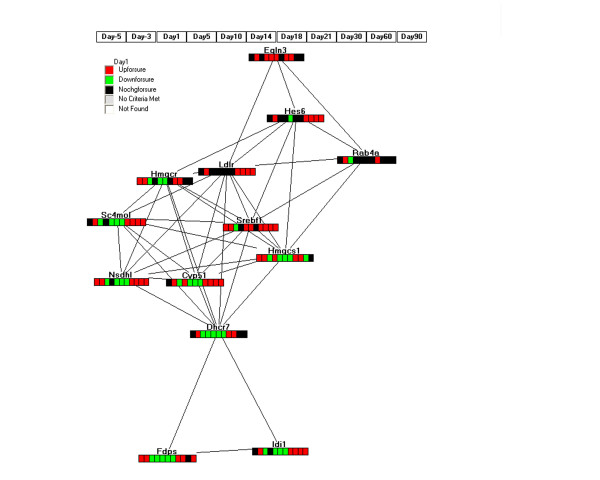
Manipulation and filtering of GTAN to gain insights of gene-gene relationships. The GTAN from Fig. 12 was merged into a gene-gene network through shared terms: if two genes share a common term, then draw a line in between these two genes and get rid of the term and its original association lines, and then the graph was rebuilt by SVG (see Additional file 14). Before merging, some generic GO terms (high rank in GO hierarchy, e.g. physiological process) were eliminated for simplicity purpose. Genes are selected by highlighting in red for further manipulation (see Additional file 14). Then the obtained PSCP file containing the merged network was colored by the CRI files from the time course experiments (same CRI files as in Fig. 5).